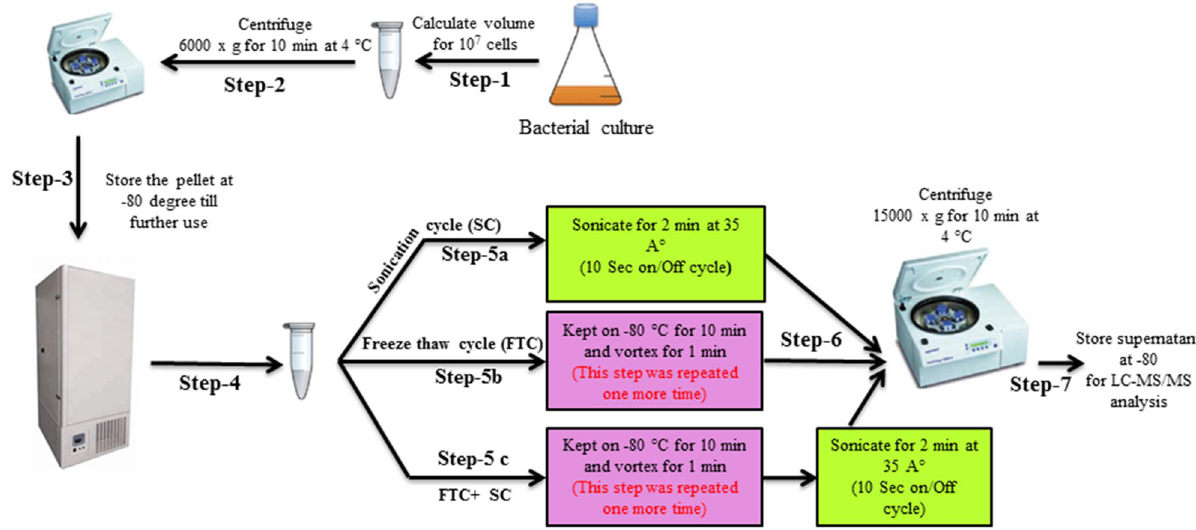
Figure 1. Workflow of metabolite extraction: Cell pellets were used for metabolites extraction using 3 extraction protocols (i) Sonication cycle, SC (ii) Freeze–thaw cycle, FTC (iii) Freeze–thaw followed sonication cycle, FTC +